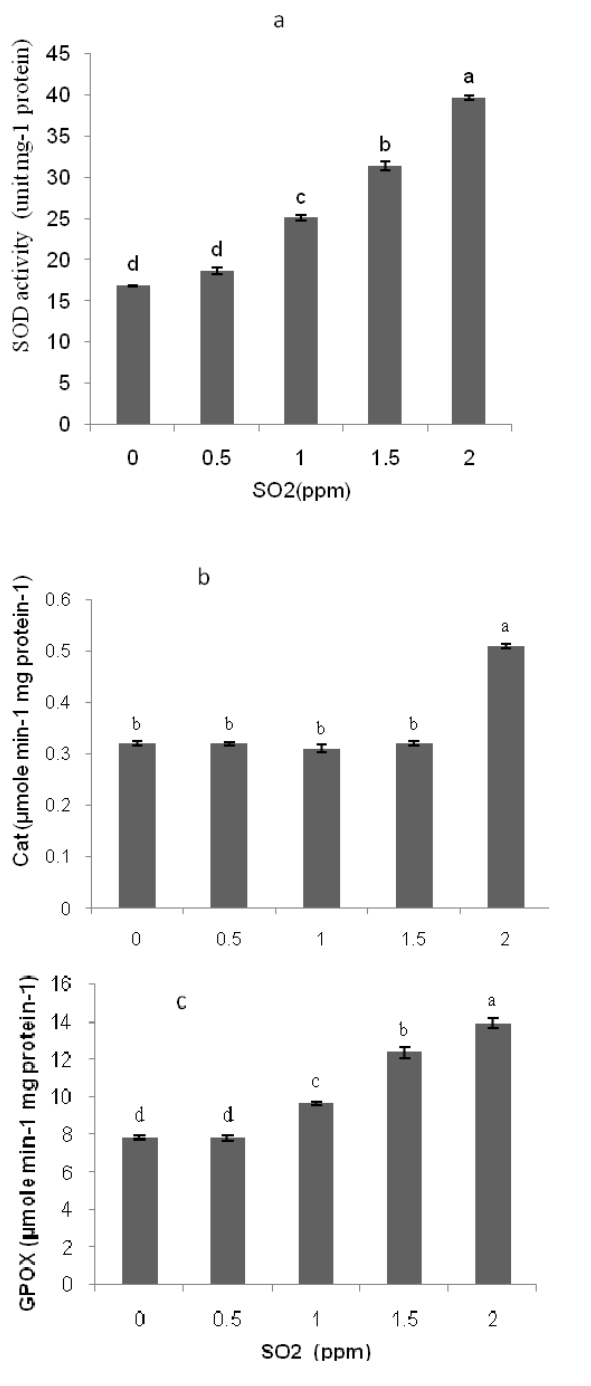
Fig. 2. SOD (a), CAT (b) and GPOX(c) activity in the leaves of alfalfa under SO 2 pollution in 45 days plants. Data are mean ± SE. Different letters indicate that the mean value is significantly different (p<